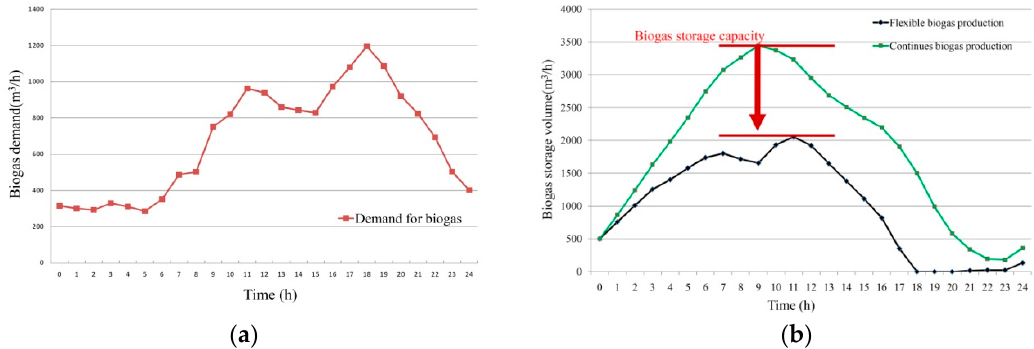
Figure 5. Comparison of required biogas storage capacity in continues and flexible biogas production mode based on the biogas demand of biogas plant. ( a ) Biogas demand of the biogas plant; ( b ) Comparison of the required biogas storage capacity.